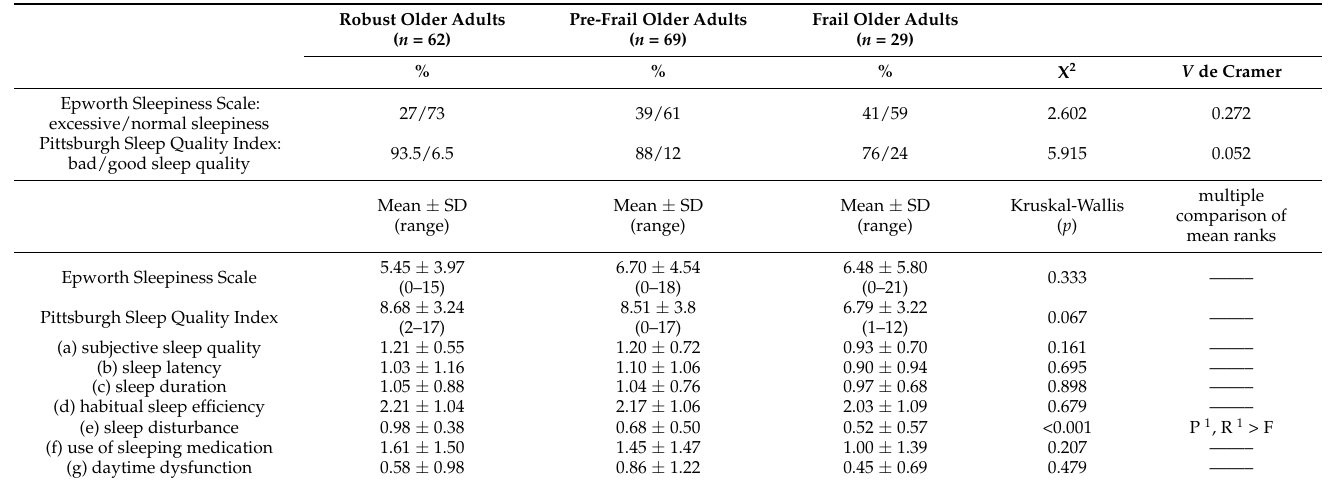
Table 5. Group differences observed in the Epworth Sleepiness Scale and Pittsburgh Sleep